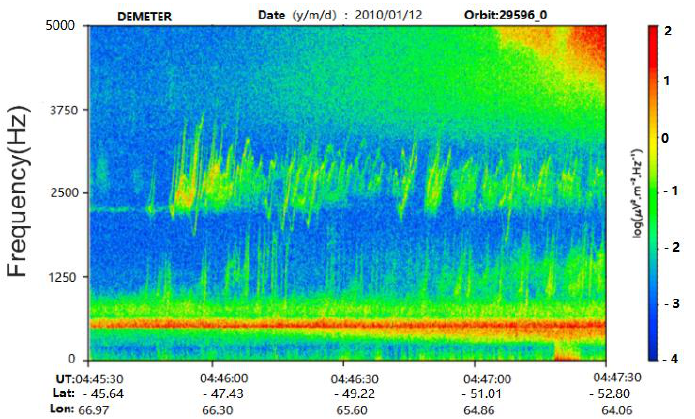
Figure 2. The spectrogram of VLF/ELF radiation signal excited by PLHR recorded by Demeter satellite on 12 January 2010.